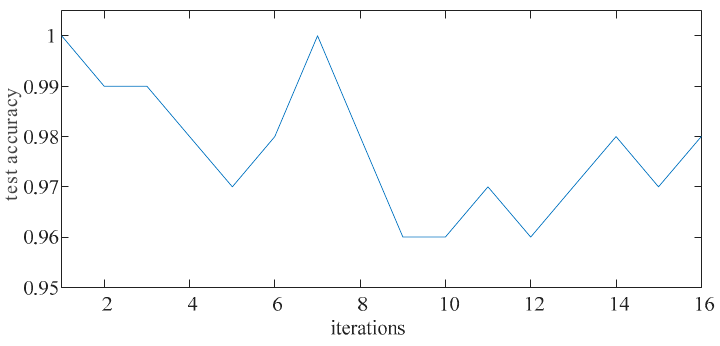
Figure 9. Test results of model.